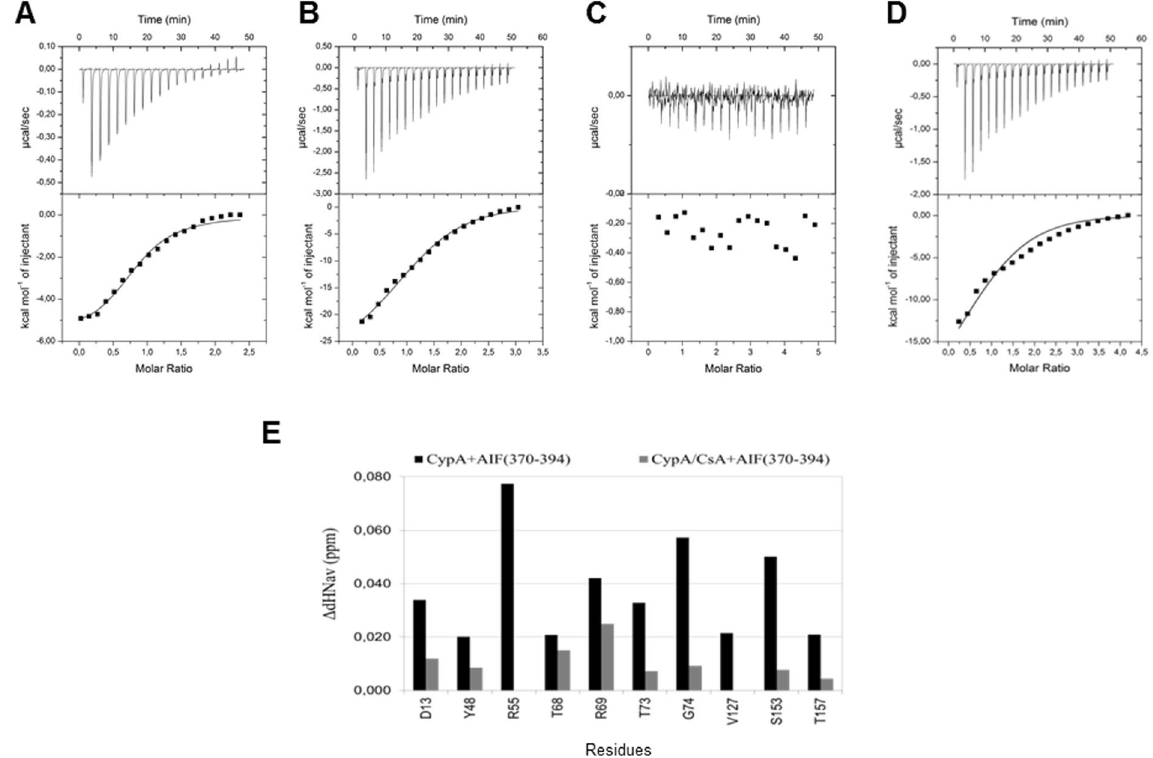
Figure 5. ITC binding assay. ( A , B ) Calorimetric titration of AIF(370-394) and CsA with CypA, respectively. The top panels show the heat signal for AIF(370-394) ( A ) and CsA ( B ) injections into a cell containing CypA at 25 °C. The bottom panels show the integrated heat of each injection after correction for the heat of dilution of ligands. Curves represent the best fit to a single-site binding model. ( C , D ) ITC competition assays. ( C ) Calorimetric titration of the preformed complex CsA-CypA with AIF(370-394). The top panel shows the heat signal for AIF(370-394) injections into a cell containing CypA/CsA complex at 25 °C. ( D ) Calorimetric titration of the AIF(370-394) - CypA complex with CsA. The top panel shows the heat signal for CsA injections into a cell containing CypA/AIF(370-394) complex at 25 °C. ( E ) Bar graphs of the Δ HN av as a function of the amino acid residue upon addition of AIF(370-394) to the free CypA (black) and the complex CypA/CsA (gray).